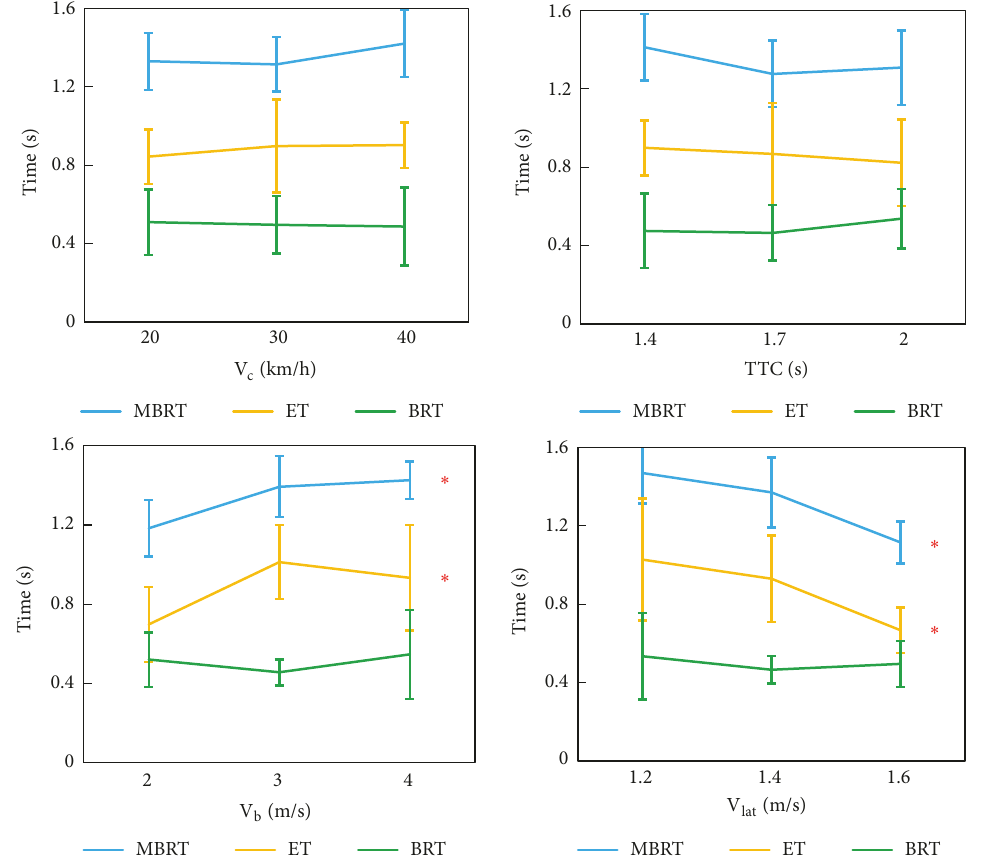
Figure 13: The average ( ± SD) of MBRT, ET, and BRT at three levels of the four parameters in SSR.